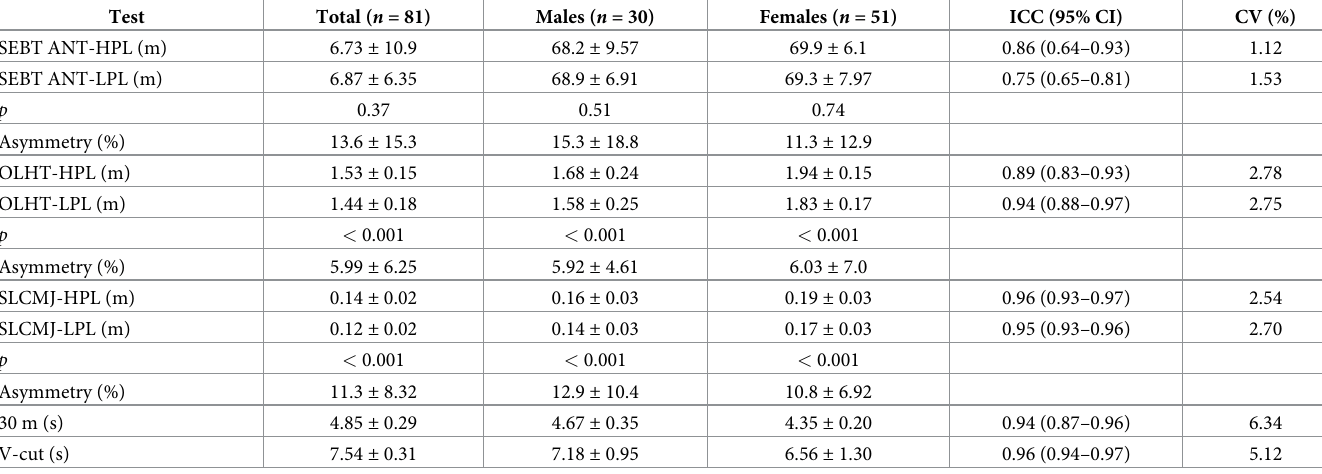
Table 2. Mean test scores ± standard deviations and within-session reliability data for the star excursion balance test (SEBT), one legged hop test (OLHT) and single leg countermovement jump (SLCMJ), comparing the highest and lowest performing limbs during each